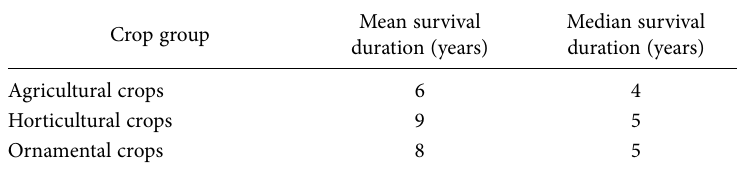
Table 2. Mean and median survival durations